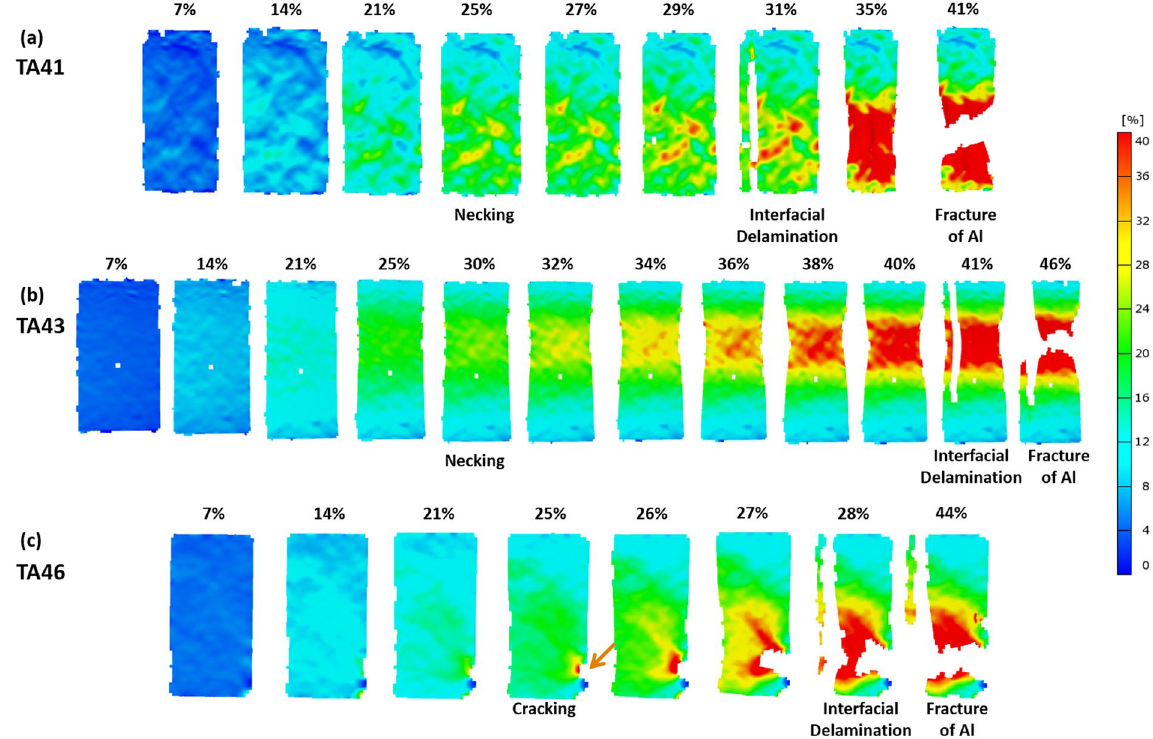
Figure 6. Digital images of strain distribution taken during tensile tests. Digital images of the ( a ) TA41, ( b ) T43, ( c ) TA46 specimens. Strains at the necking, cracking, and interfacial delamination points are described above each digital